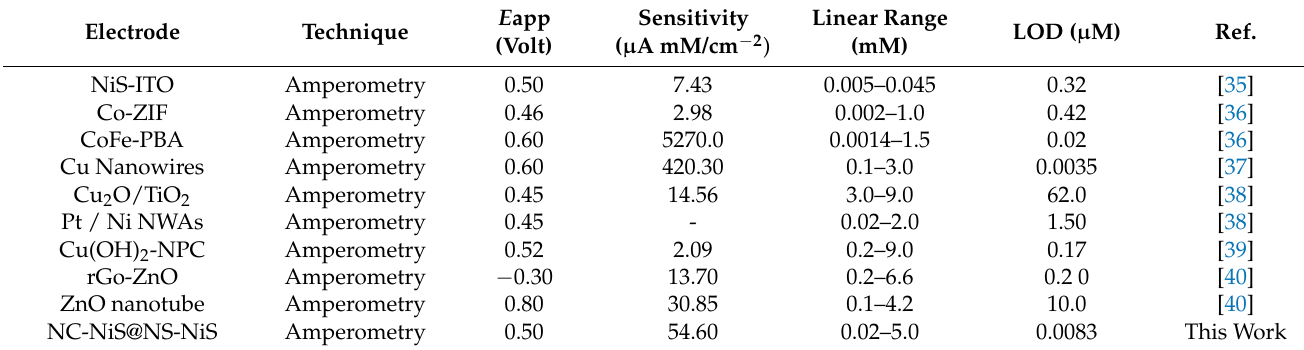
Table 1. Comparison of the present glucose sensor based on NC-NiS@NS-NiS|NF reported in literature.